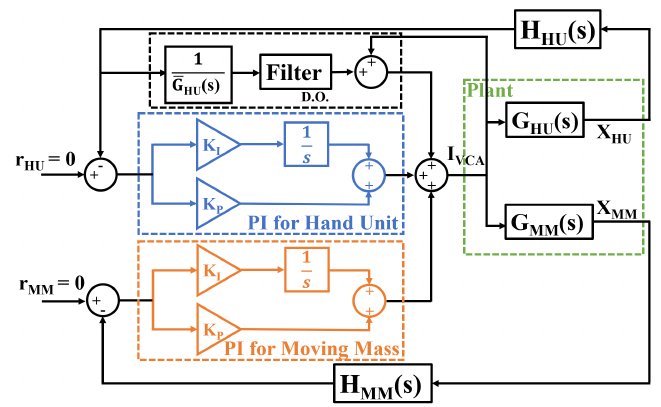
Figure 12. Block diagram of the controller